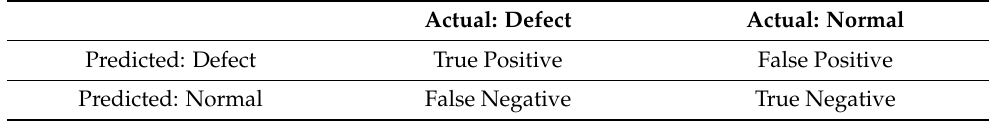
Table 1. Confusion matrix for defect detection. Actual: Defect Actual: Normal Predicted: